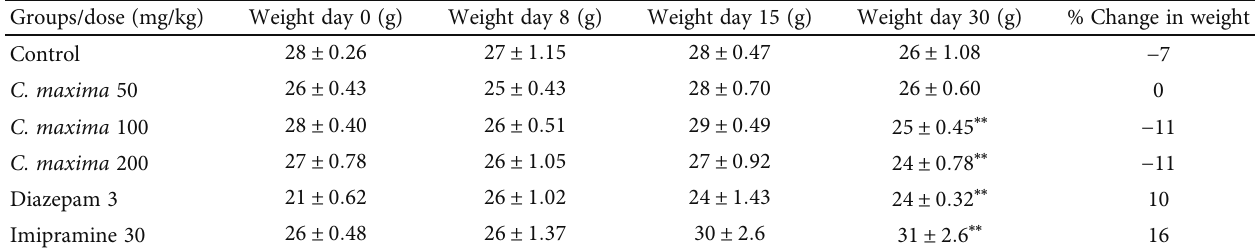
Table 1: E ff ect of C. maxima seed extracts on weight in mice.